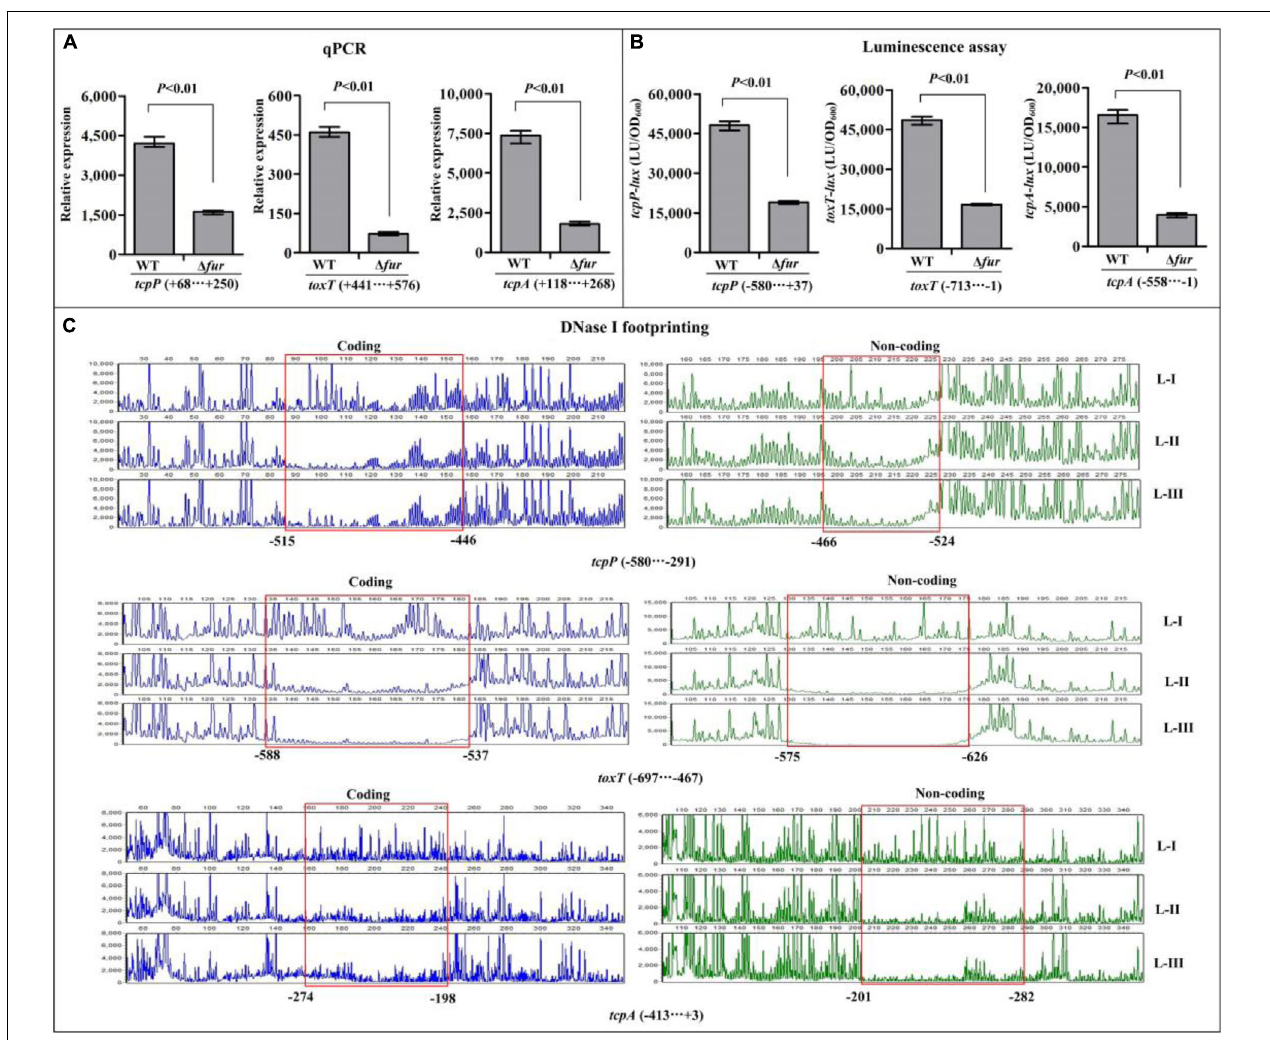
FIGURE 4 | Regulation of tcpP , toxT , and tcpA by Fur. The qPCR (A) and DNase I footprinting assays (C) were done as Figure 3 , while the luminescence assay (B) was done as Figure 2 . L-I, -II, and -III contain 0, 2.95, and 8.85 pmol of His-Fur,